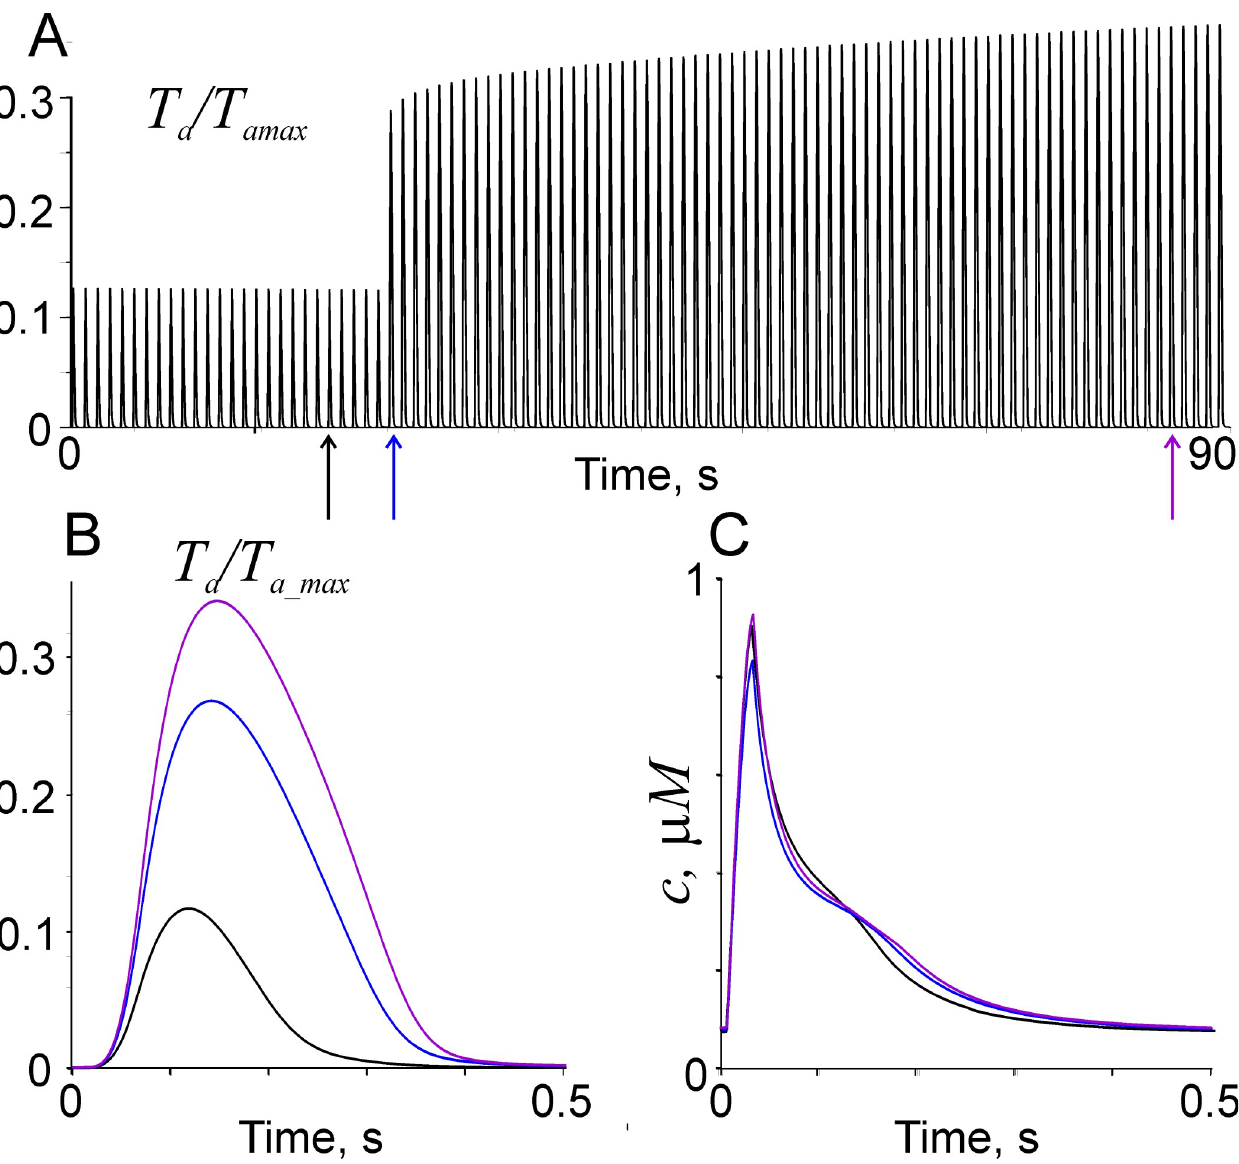
Fig 3. The effect of sarcomere length on twitch contractions at the stimulation rate 1 Hz. A: isometric twitches before and after a change of sarcomere length from 1.9 to 2.2 μ m; B, C: calculated normalised active tension and Ca 2+ concentration in cytosol for twitches shown by arrows of the same colour in A.